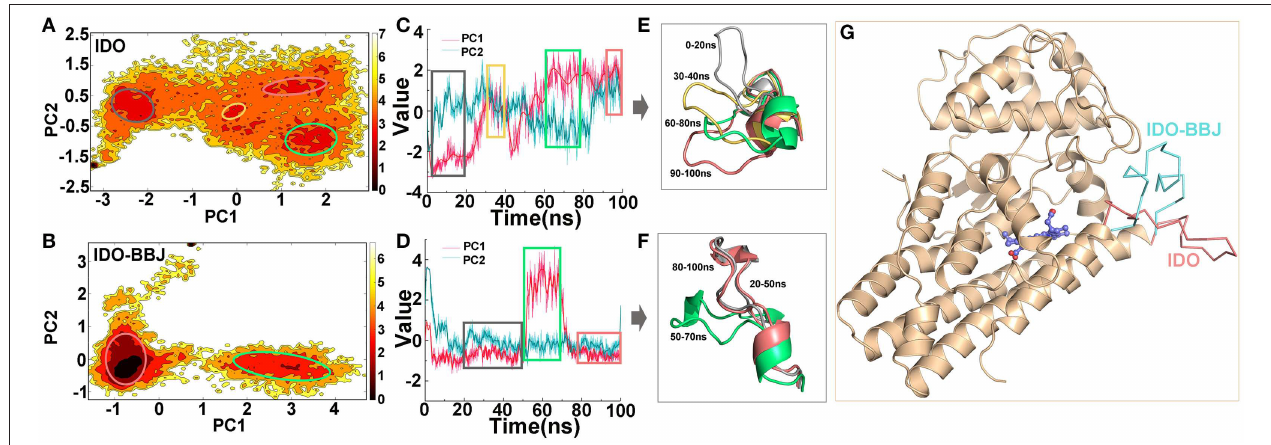
FIGURE 4 | Free energy surface analyses of Q360-G381 loop in IDO1. Free energy landscapes of IDO and IDO-BBJ systems (A,B) . Conformational fluctuations of the first principal component (PC1) and the second principal component (PC2) vs. simulation time in the two systems, where the period corresponding to the lower energy conformation can be determined (C,D) . Conformational change of Q360-G381 loop in different time periods (E,F) . The open and close structures of Q360-G381 loop, which are colored in red and blue, respectively (G)